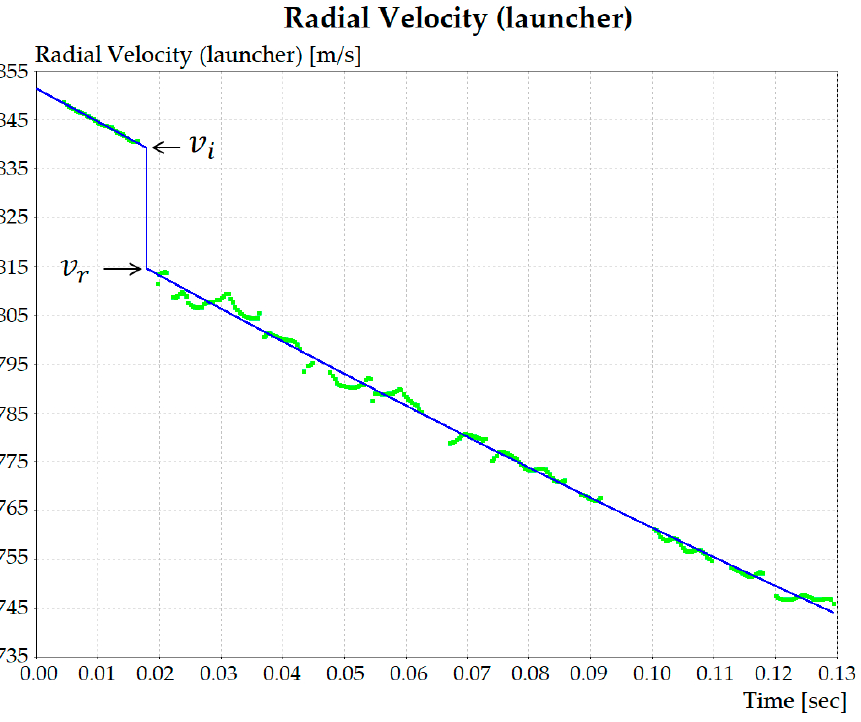
Figure 3. Experimental points obtained from the radar spectrum and the FFT curve fitting.